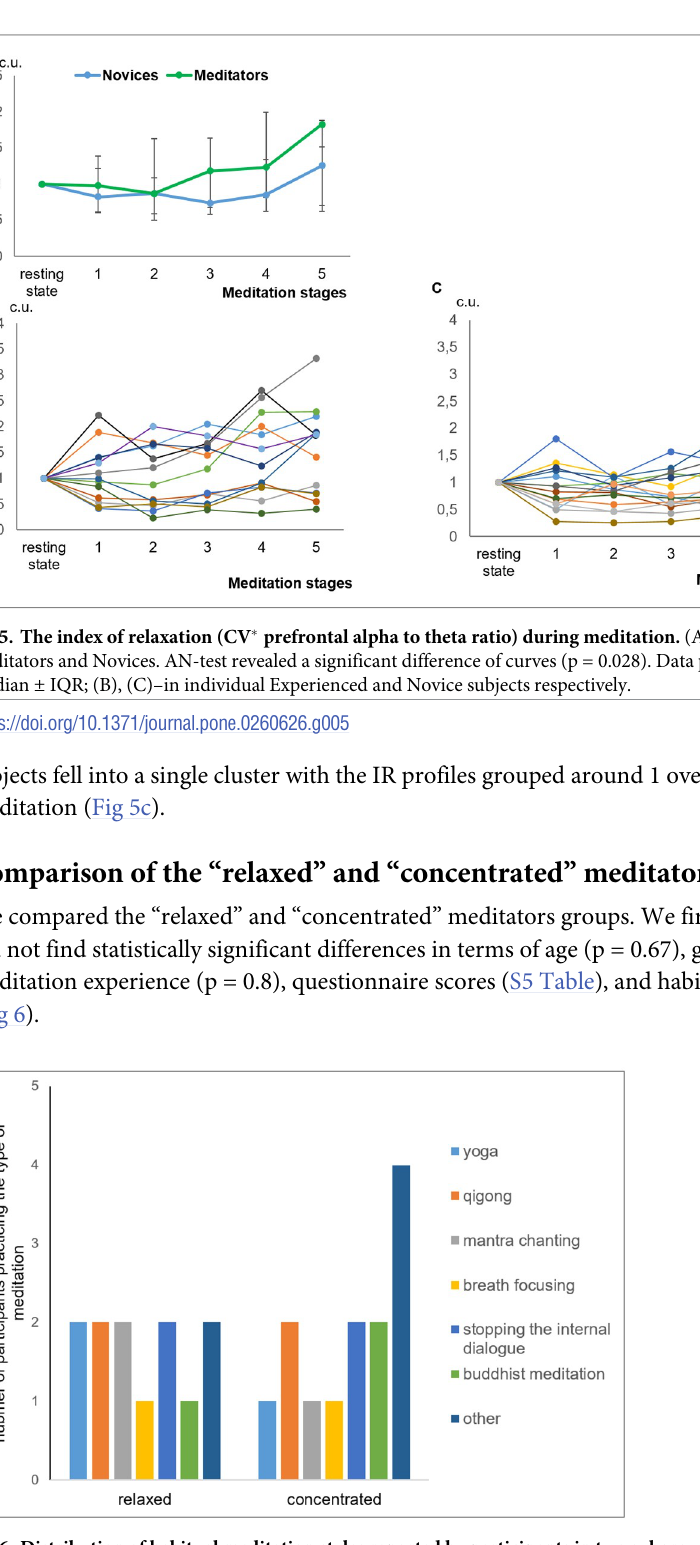
Fig 6. Distribution of habitual meditation styles reported by participants in two subgroups. Please note that most of the subjects reported more than one habitual meditation